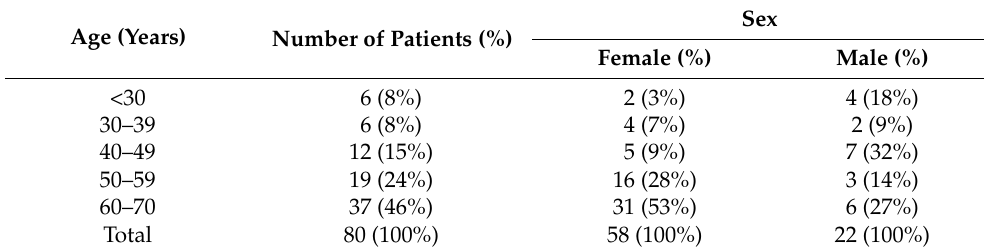
Table 1. Characteristics of study participants.